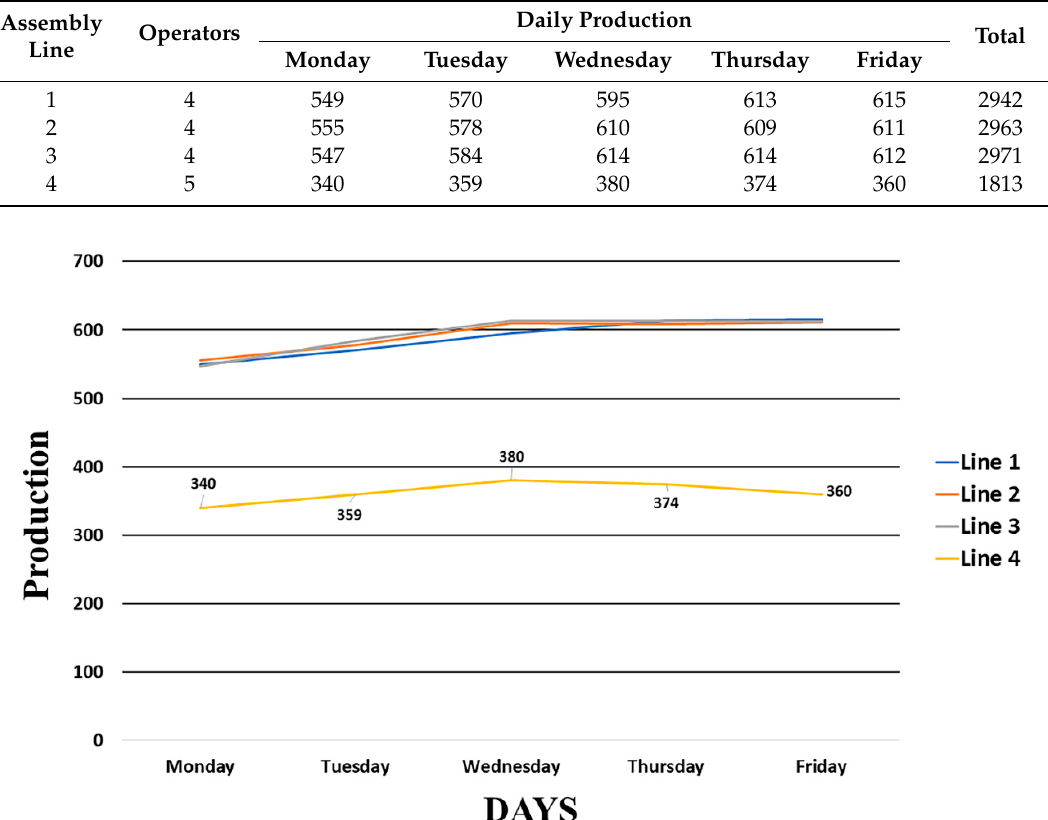
Table 10. Comparison of production increase: Original methodology versus new methodology.